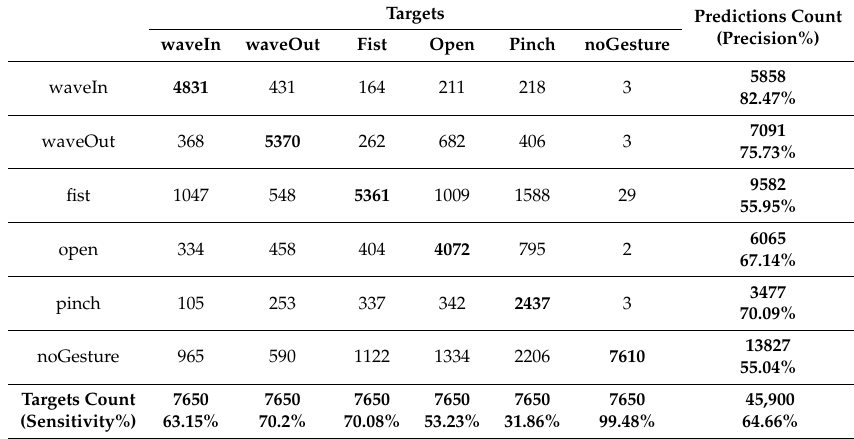
Table 2. Confusion matrix of the Myo bracelet using the manufacturer’s model and suggested sensor position. Classification accuracy = 64.66%.